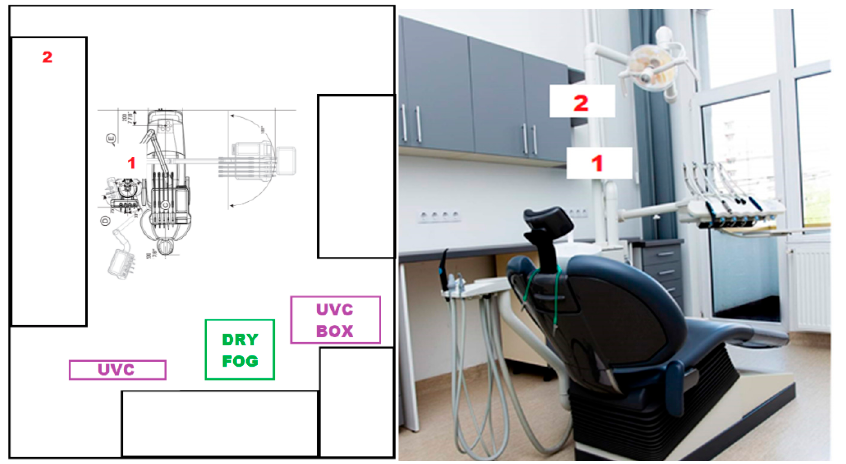
Figure 1. Treatment room layout.